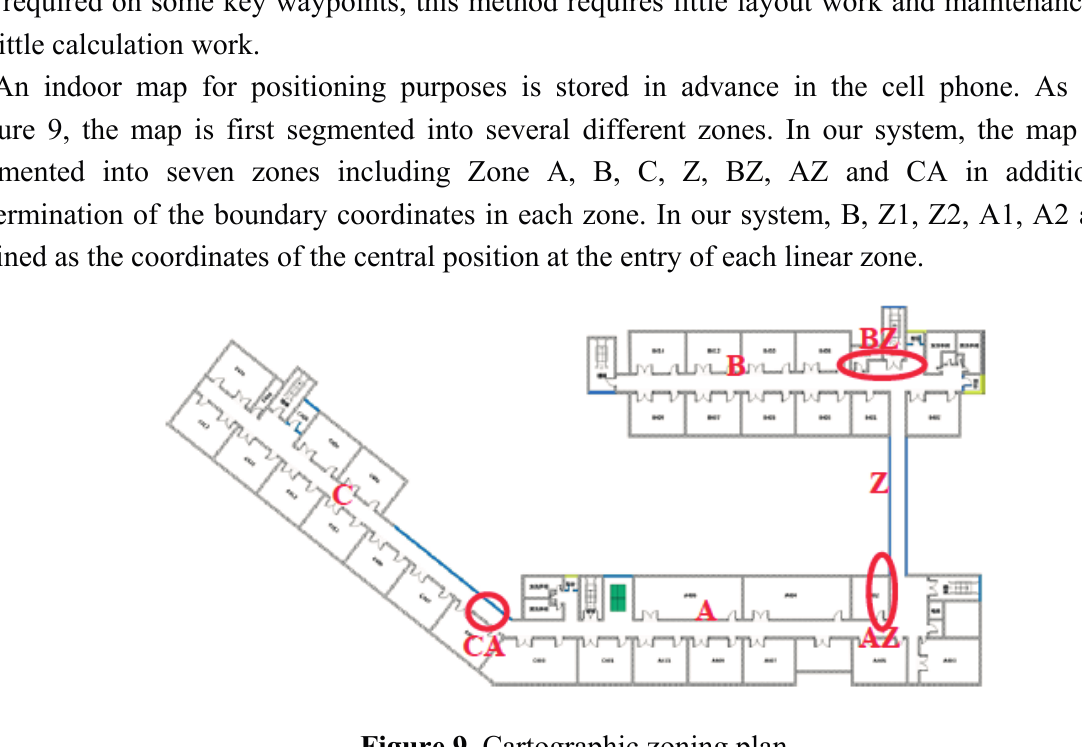
Figure 9. Cartographic zoning